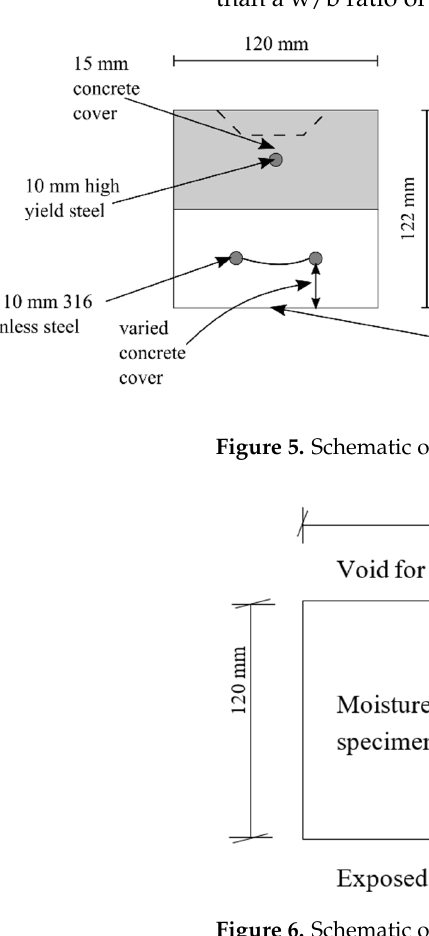
Figure 6. Schematic of moisture prism specimen.